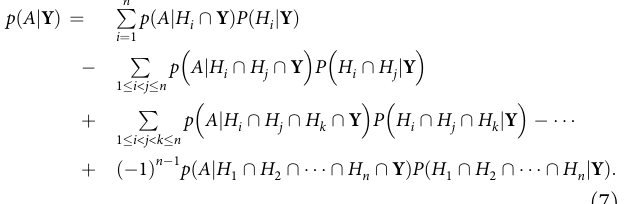
GMST change to melt and the sea ice sensitivity,